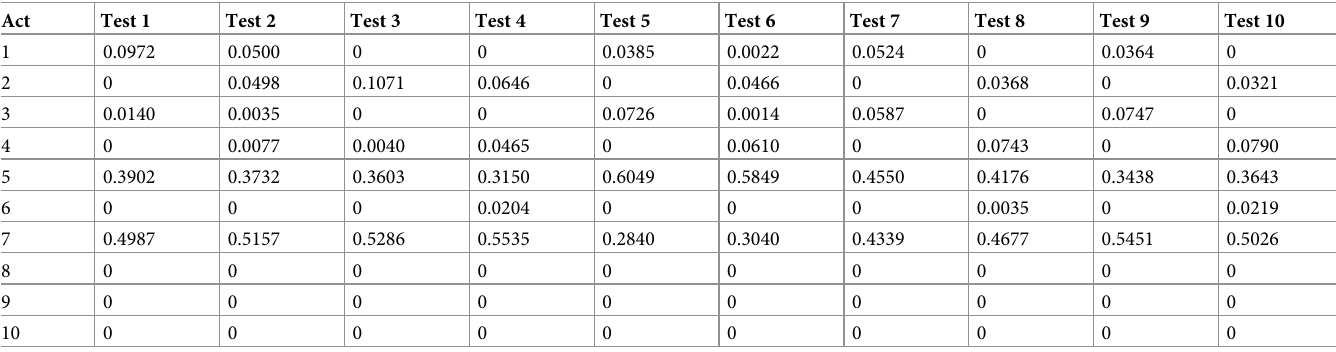
Table Legends: Act—activities. Test #—simulation test. Each column—ending frequencies for corresponding activities for P 1 .